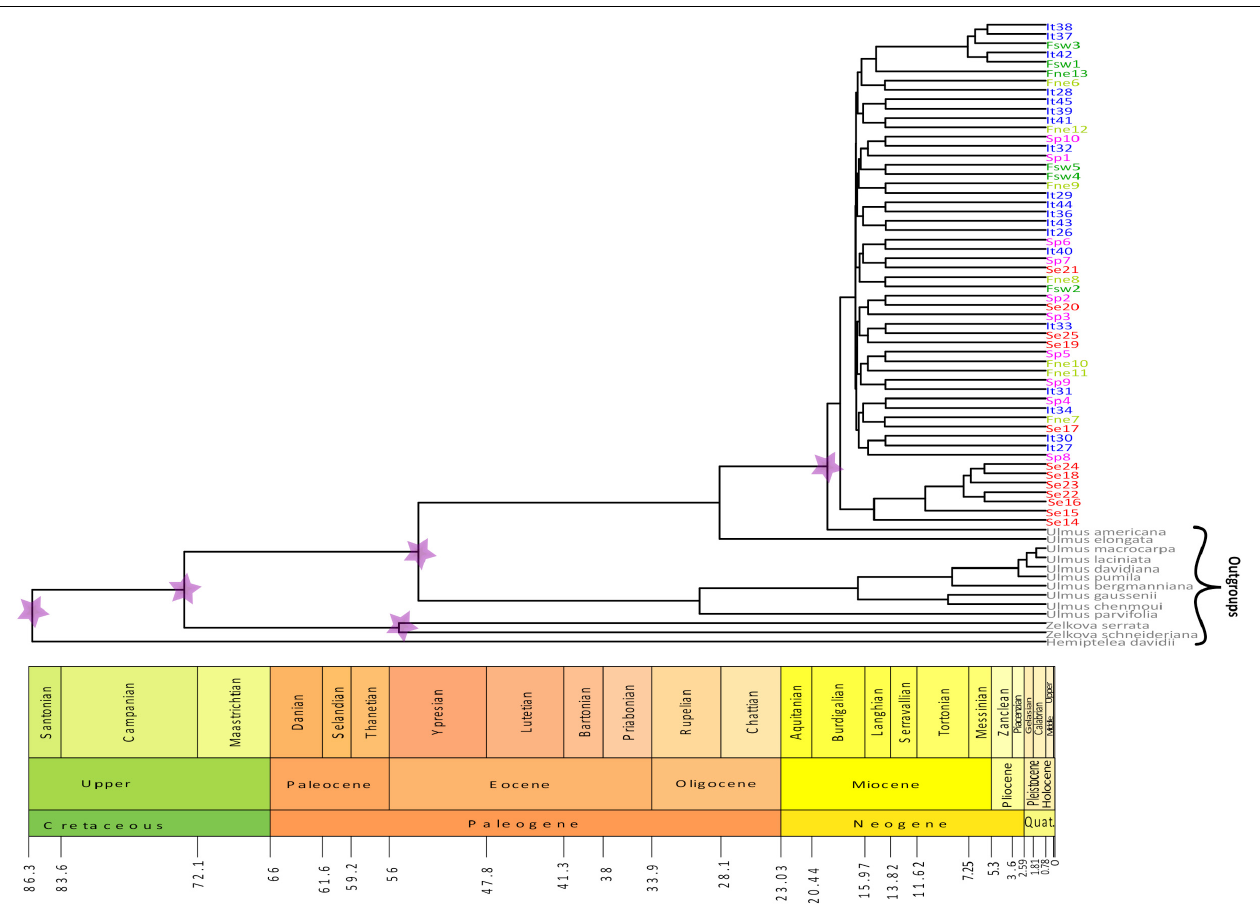
FIGURE 5 | Phylogenetic tree of Ulmus laevis individuals calculated using BEAST software. The tree includes 54 U. laevis samples from five populations (indicated by different colors: blue = Italy, dark green = France_SW, light green = France_NE, red = Serbia, pink = Spain) and 13 outgroups species within Ulmaceae family: Ulmus americana (NC_044473.1); Ulmus elongata (NC_046061.1); Ulmus macrocarpa (NC_032720.1); Ulmus laciniata (MT742253.1); Ulmus davidiana (NC_032718.1); Ulmus pumila (MW279236.1); Ulmus bergmanniana (NC_057601.1); Ulmus gaussenii (NC_037840.1); Ulmus chenmoui (NC_037758.1); Ulmus parvifolia (MT701612.1); Zelkova serrata (NC_040958.1); Zelkova schneideriana (NC_041074.1); and Hydrangea davidii (MK070168.1). The stars on nodes indicate the five points of age constraints on divergent time. Time axis shows the age in Mya. Geological time scale visualized with the R strap